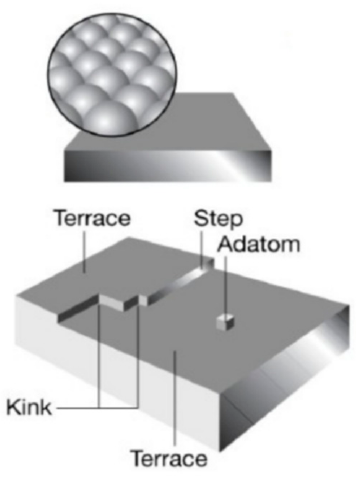
Figure 2. Schematic diagram of the surface microstructure of biochar.